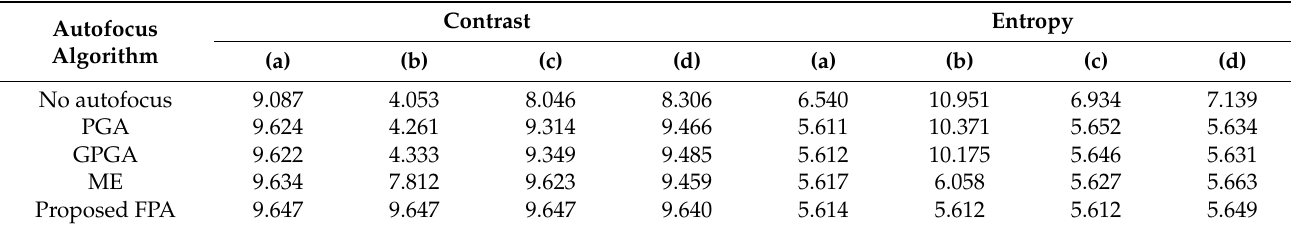
Table 6. Comparison of performance for different autofocus algorithms for scene B.